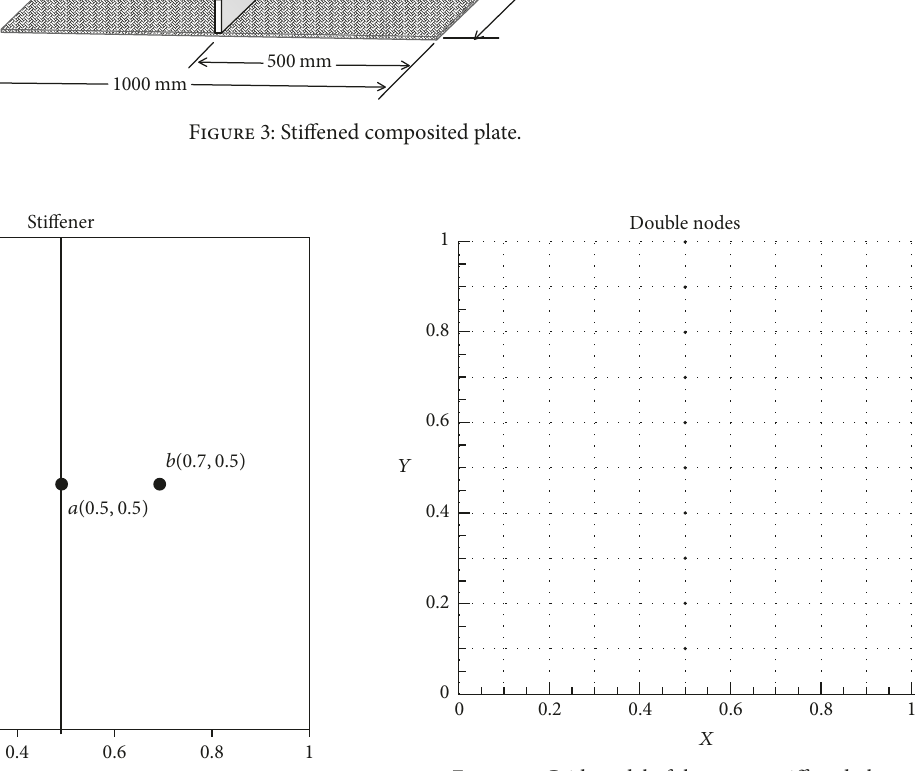
Figure 5: Grid model of the square stiffened